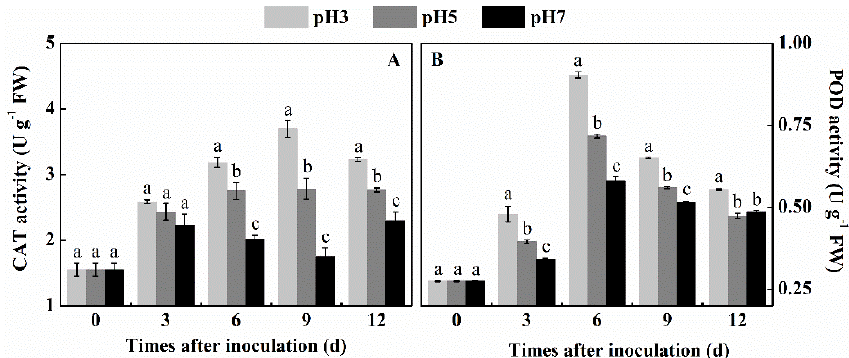
Figure 4. Effect of inoculation of T. roseum at different pH conditions on the activity of CAT ( A ) and POD ( B ) of colonized apple fruits. Bars indicate standard error (±SE). Different letters indicate statistically significant differences ( p < 0.05) among treatments.